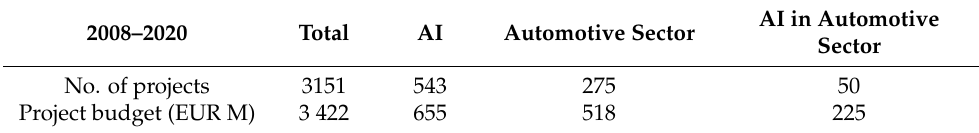
Table 3. Portuguese R&D project data from 2008 to 2020.